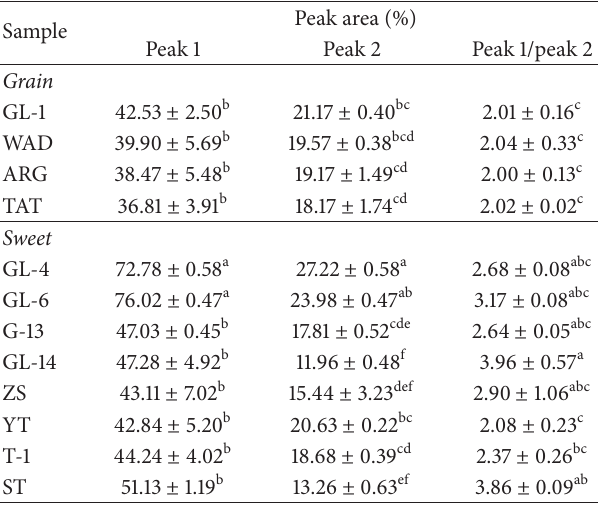
Table 6: Molecular weight distribution of sweet and grain sorghum